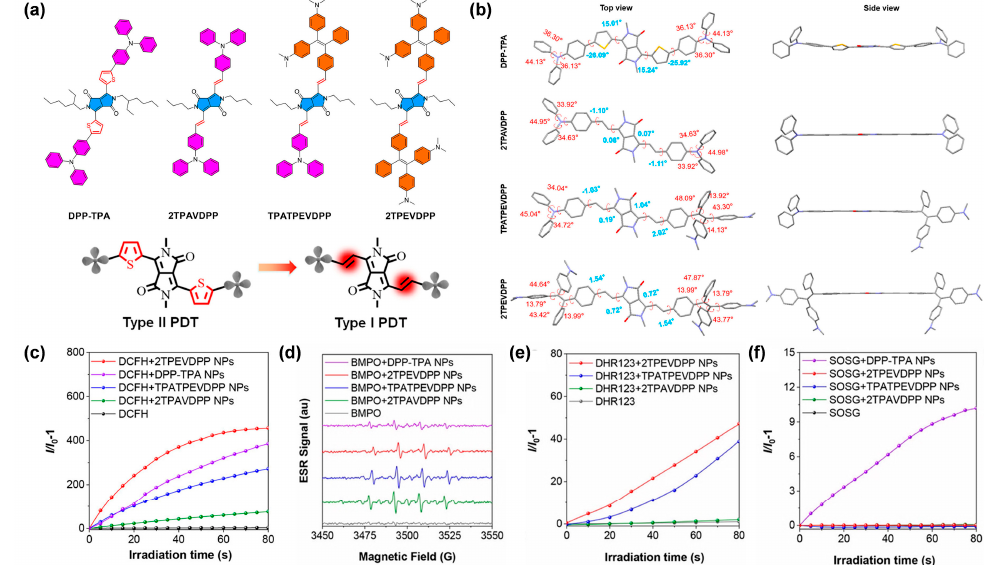
Figure 4. ( a ) Chemical structures and design principles of DPP-TPA, 2TPAVDPP, TPATPEVDPP